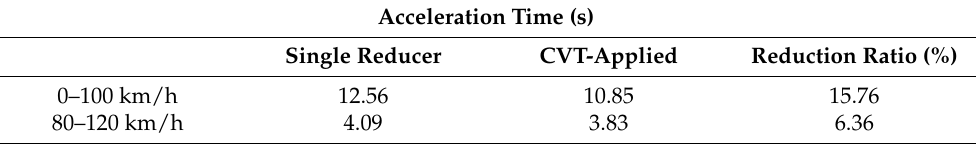
Table 7. Comparison of EV